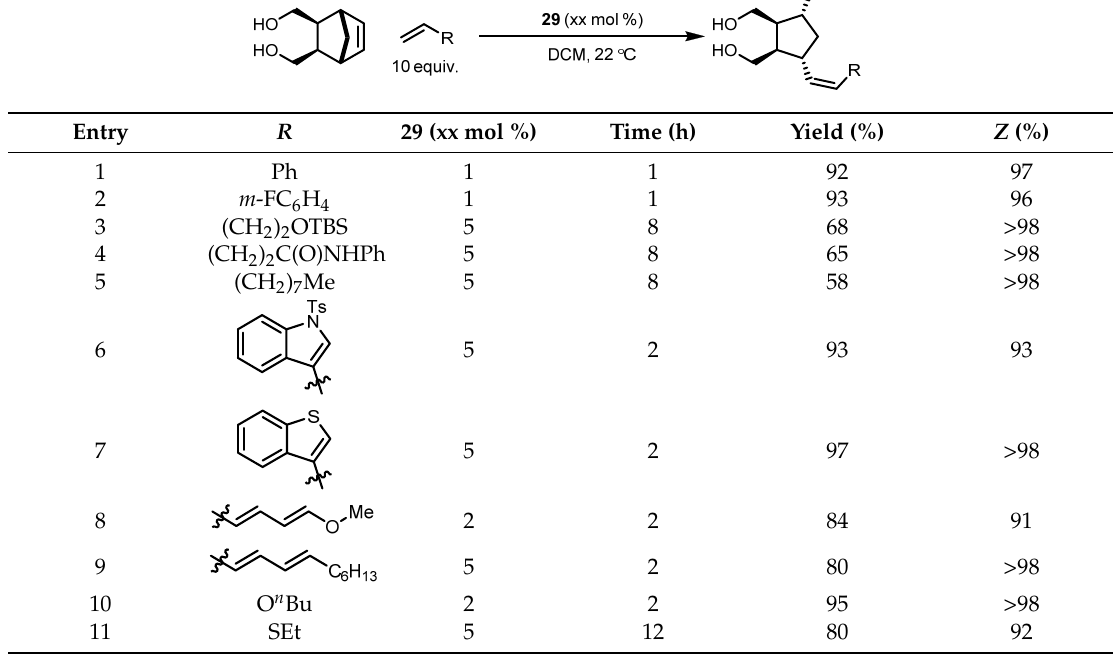
Table 10. Ring-opening/cross metathesis (ROCM) of norbornene diols with terminal olefins.